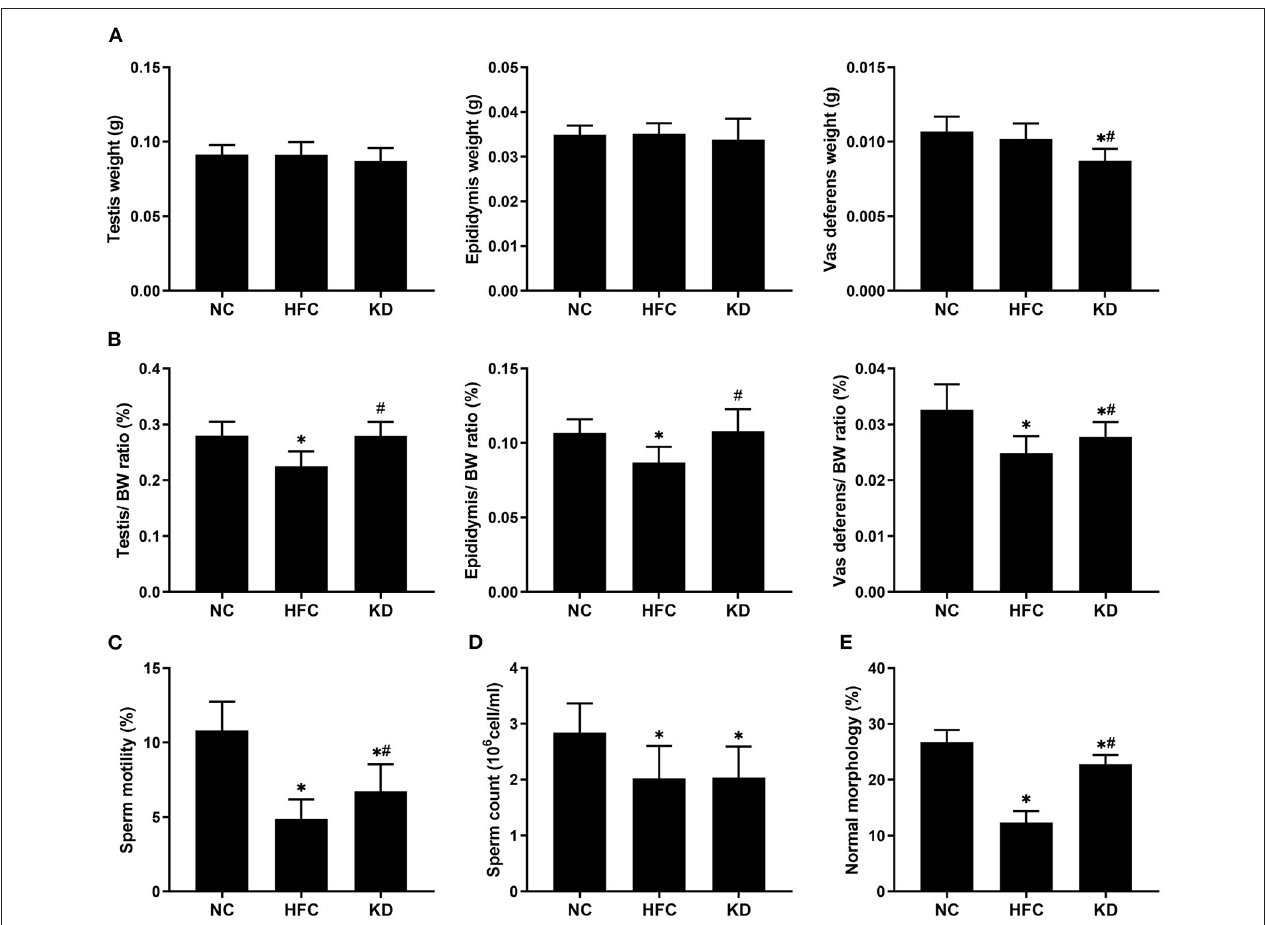
FIGURE 3 | Effects of a high-fat and high-cholesterol diet and a ketogenic diet on (A) the weights of the testis, epididymis, and vas deferens, (B) the relative weights of the testis, epididymis, and vas deferens, (C) sperm motility, (D) sperm count, and (E) percentage of sperm of a normal morphology in male mice. * p < 0.05, compared with the NC group; # p < 0.05, compared with the HFC group. NC, normal diet; HFC, high-fat and high-cholesterol diet; KD, HFC diet changed to MCT-based ketogenic